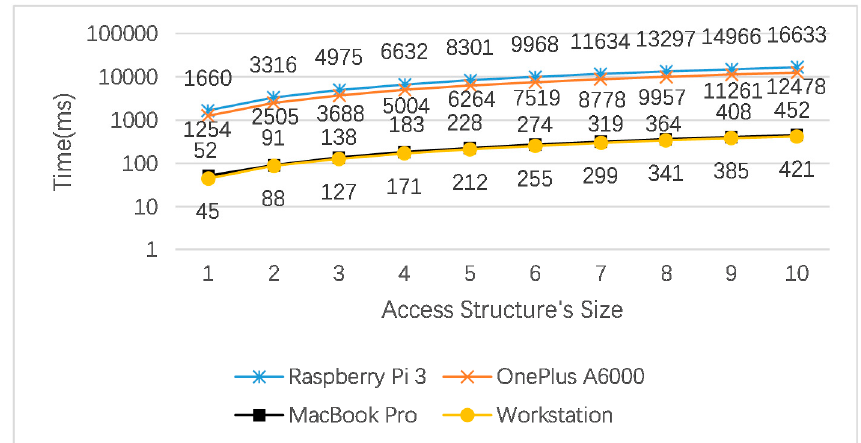
Figure 10. Performance of hybrid ABE encryption (1 KB plaintext).